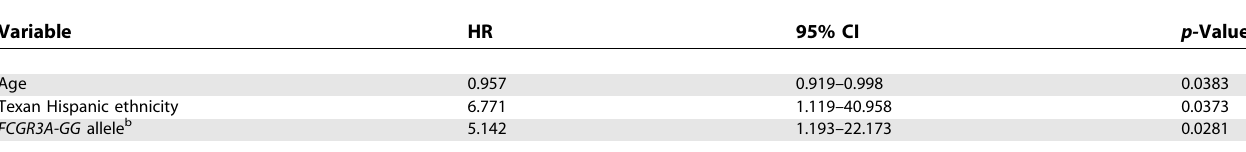
Table 5. Baseline Factors Associated with Time to ESRD among 438 PROFILE Patients with Renal Involvement by Cox Multivariable Proportional Hazards Regression